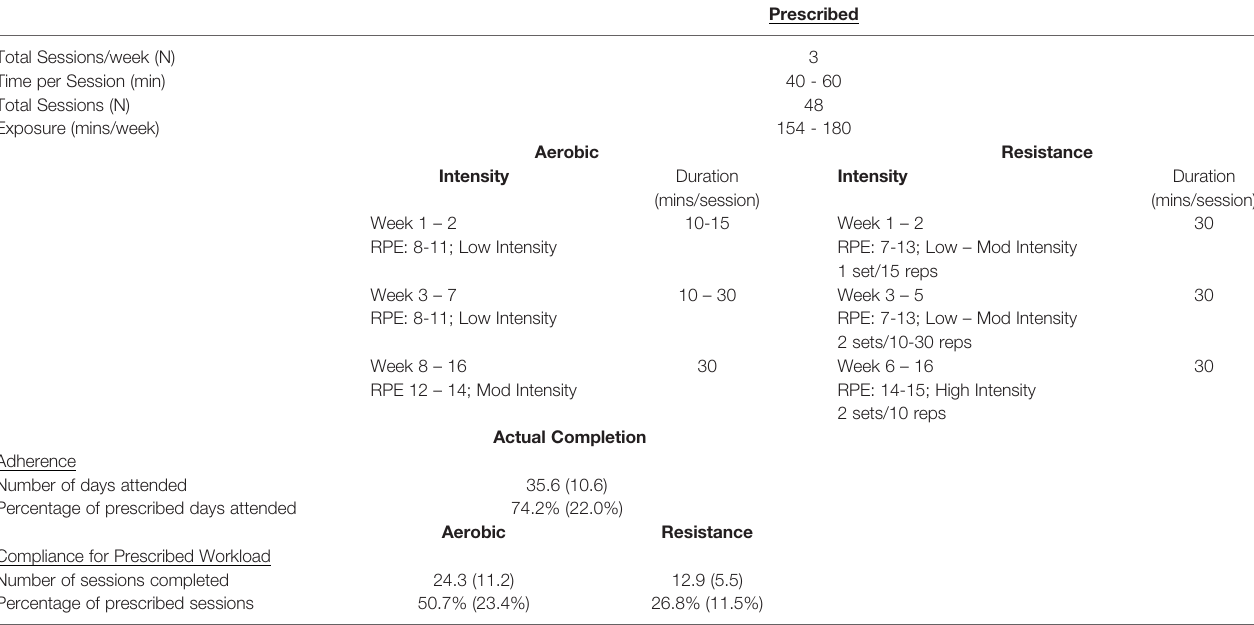
TABLE 1 | Exercise Prescription and actual exercise completion by